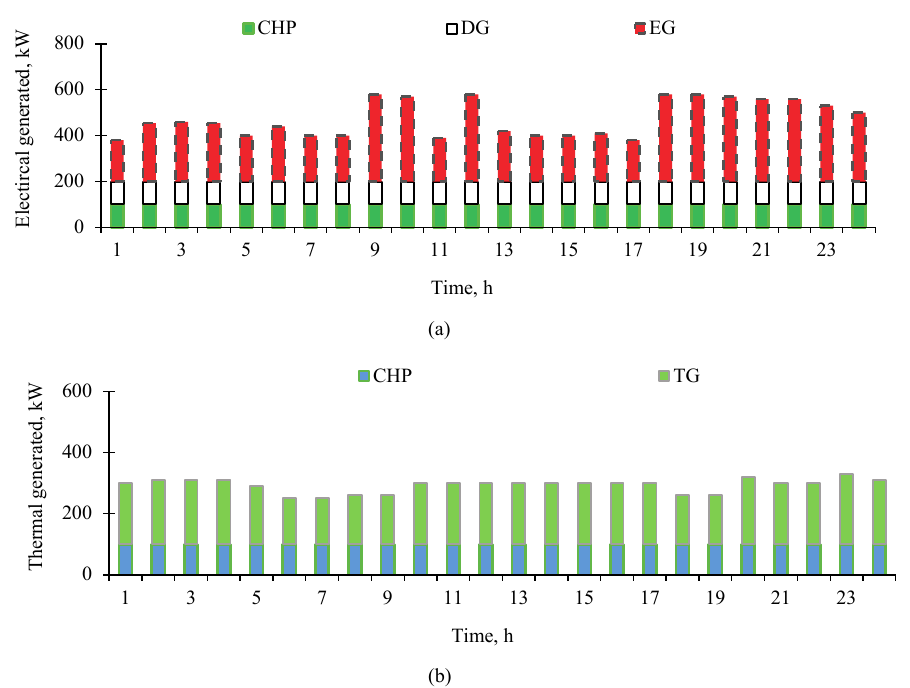
Fig. 8. Energy generation in Case B: (a) Electrical generated and (b) thermal